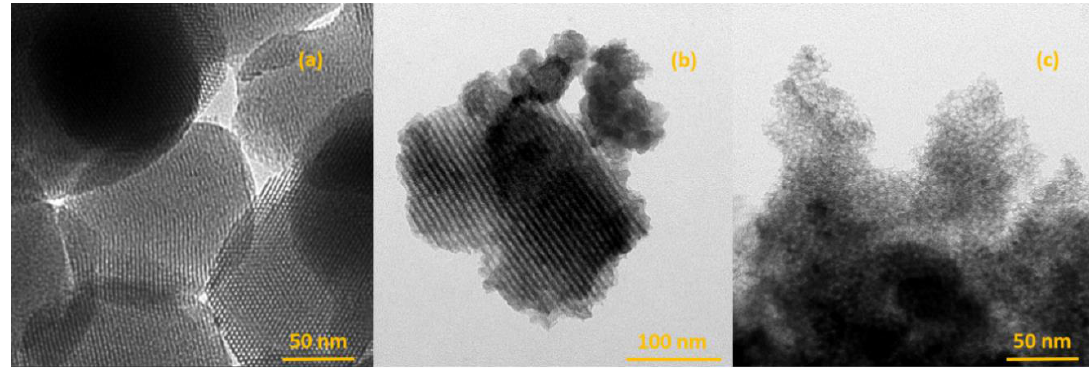
Figure 2. High magnification TEM images of CoRu-S Catalysts (S = ( a ) MCM-41, ( b ) SBA-15, ( c ) KIT-6.